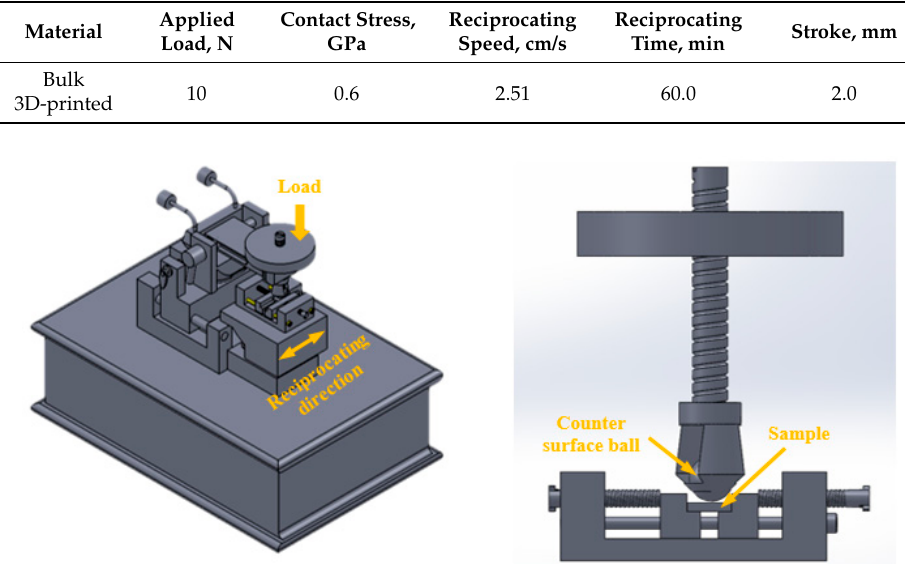
Figure 2. Schematic view of a ball-on-disk setting configuration.